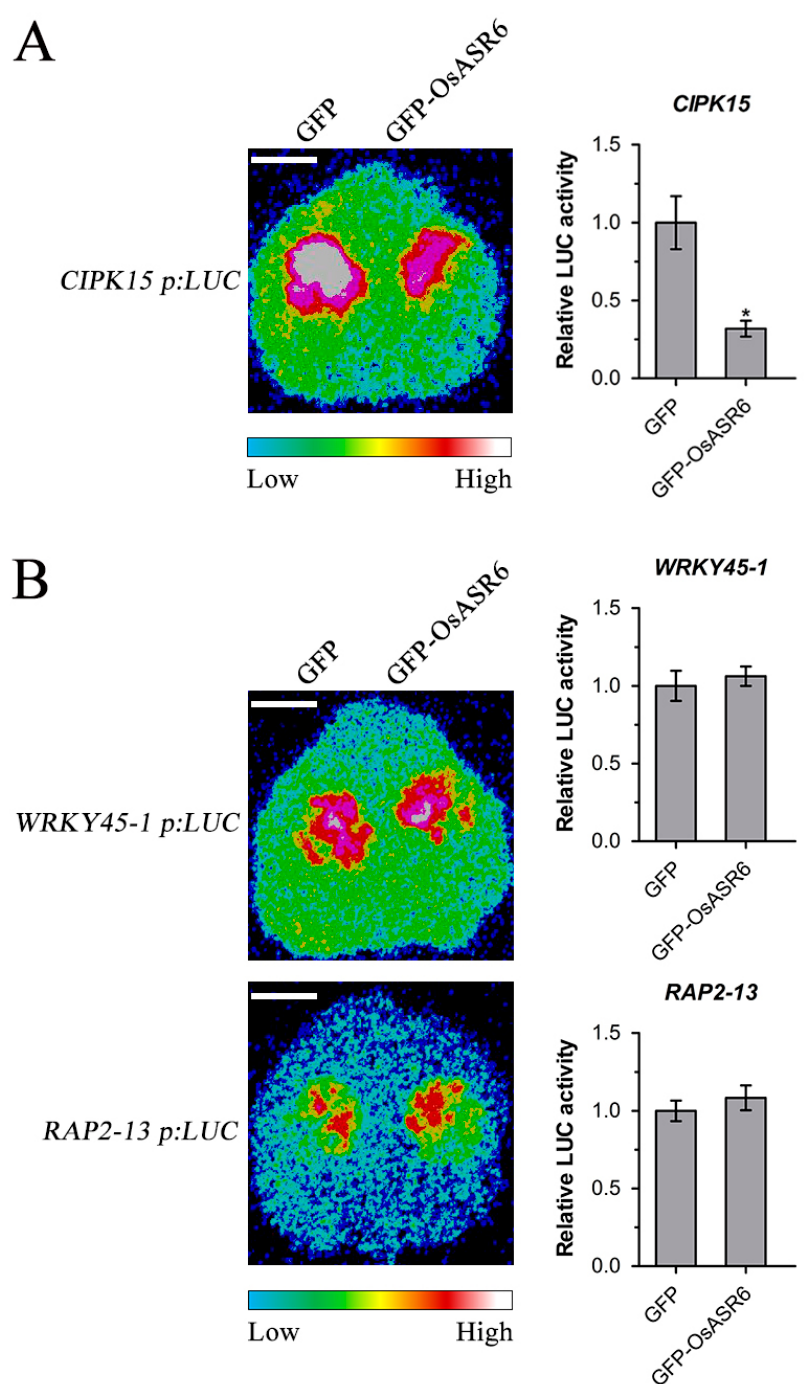
Figure 6. OsASR6 suppresses expression of CIPK15 but not WRKY45-1 and RAP2-13 in planta. Bioluminescence of Agrobacterium-mediated co-expression of GFP-OsASR6 (or GFP as control) and CIPK15 p:LUC ( A ) and WRKY45-1 p:LUC or RAP2-13 p:LUC ( B ) in N. benthamiana was detected 36 h–48 h after infiltration. Representative of three trials with similar results is shown. The bioluminescence intensity reporting the activity of luciferase (LUC) was quantified and the relative bioluminescence intensity of GFP-OsASR6 to GFP is shown. Data were analyzed by Student’s t -test and shown as the mean ± SD. Asterisks indicate significant difference between LUC-derived bioluminescence intensity affected by GFP-OsASR6 and that by GFP (* p < 0.05). Bar: 1 cm.